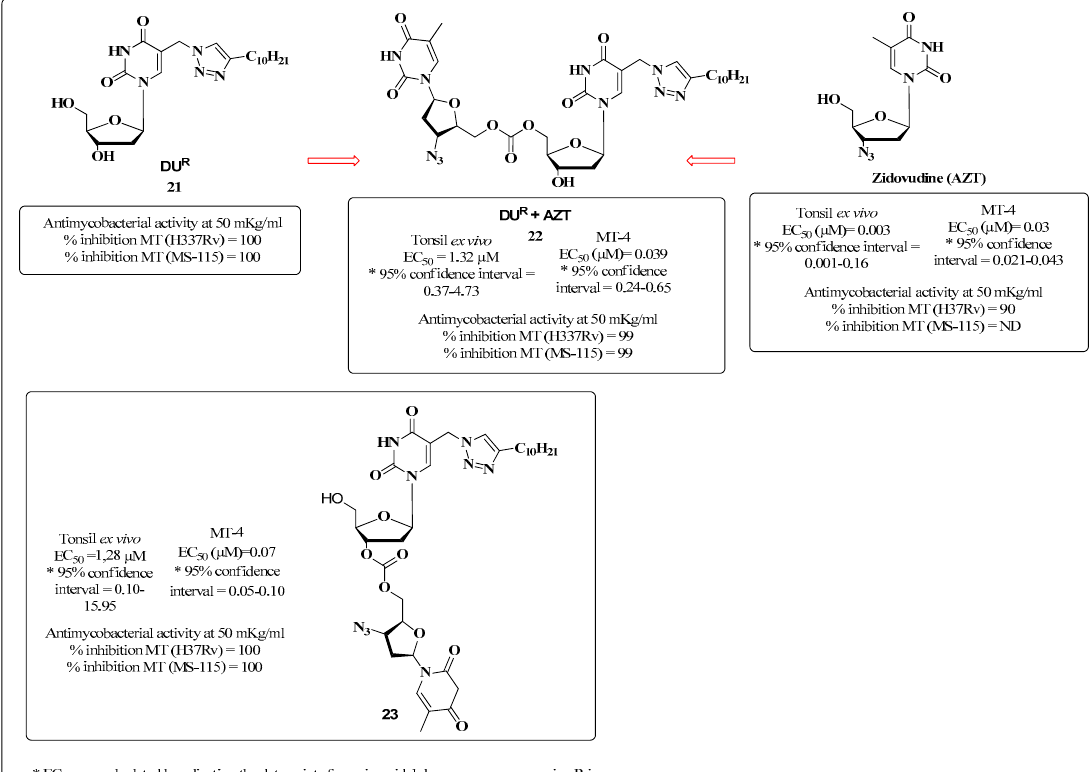
Figure 19. Potential multitarget HIV-TB 20 reported by Vasu Nair et al. in 2015 [101].